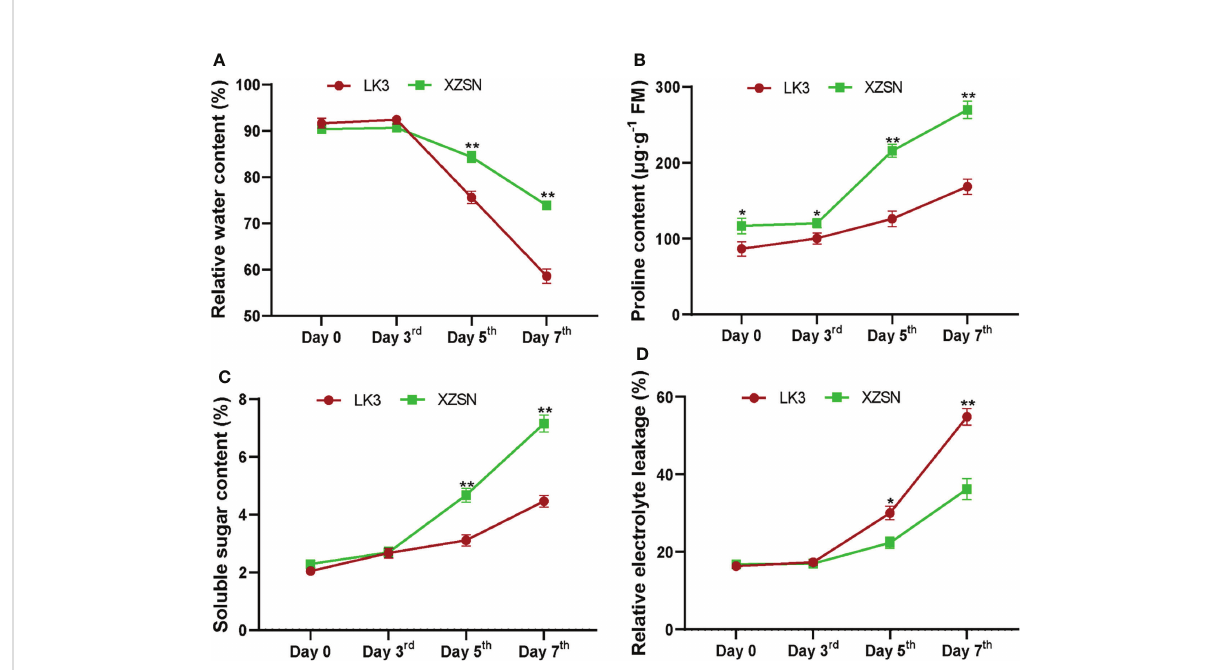
FIGURE 2 Physiological response of the drought-tolerant genotype XZSN and the drought-susceptible genotype LK3. (A) Relative water content (%), (B) proline content ( m g·g − 1 FM), (C) soluble sugar content (%), and (D) relative electrolyte leakage (%). Days 0, 3, 5, and 7 represent natural drought stress conditions by withholding water for 0, 3, 5, and 7 days after pouring suf fi cient water, respectively. Bars with one (*) and two (**) stars are signi fi cantly different at p < 0.05 and p <